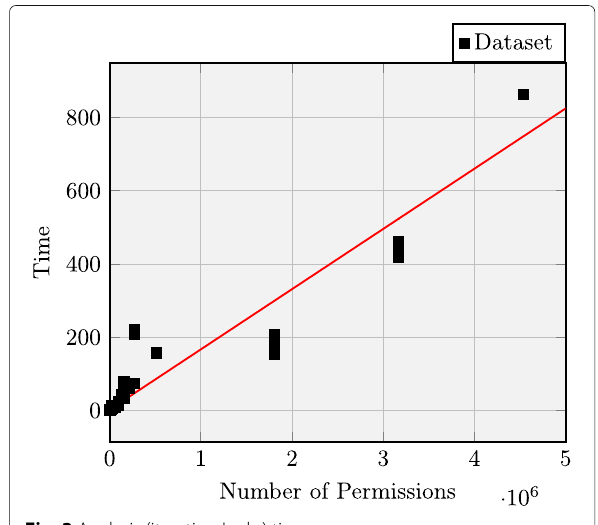
Fig. 3 Analysis (iterative Jenks) time